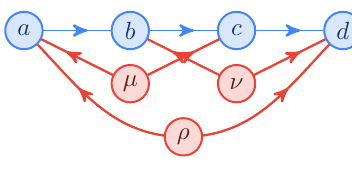
Figure 13: The Evans Causal Structure G 13